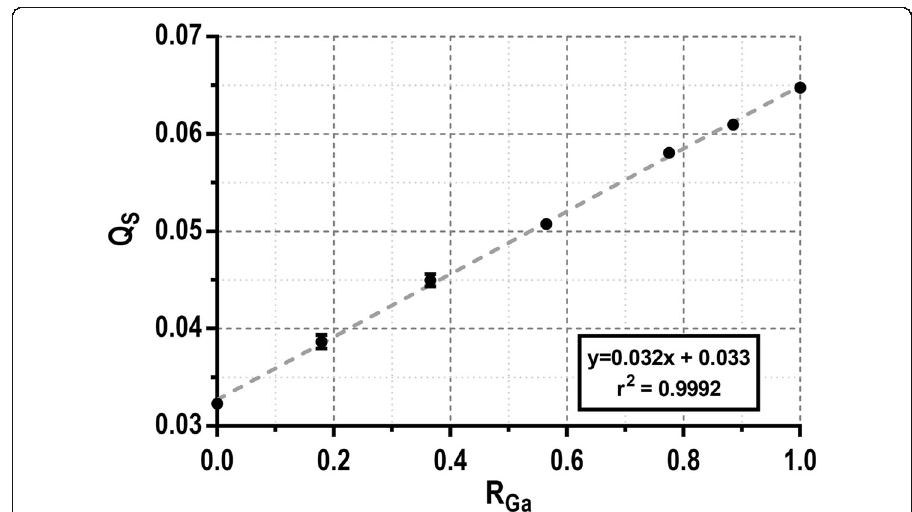
Fig. 2 Calibration of Q S values of a set of 1 ml samples with mixed 68 Ga and 18 F in different activity ratios. The linear fit (dashed line) shows an excellent linear correlation ( r 2 = 0.9992) between both datasets